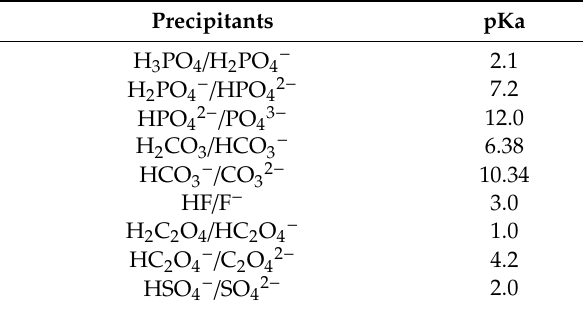
Table 1. The pKa values for various precipitants